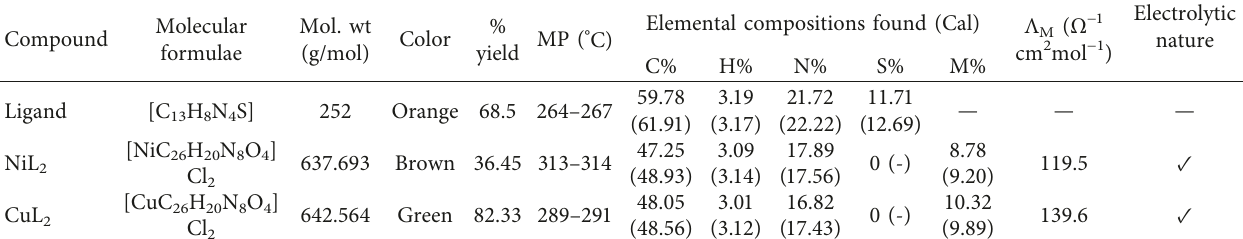
Table 1: Physical properties of newly synthesized ligand and